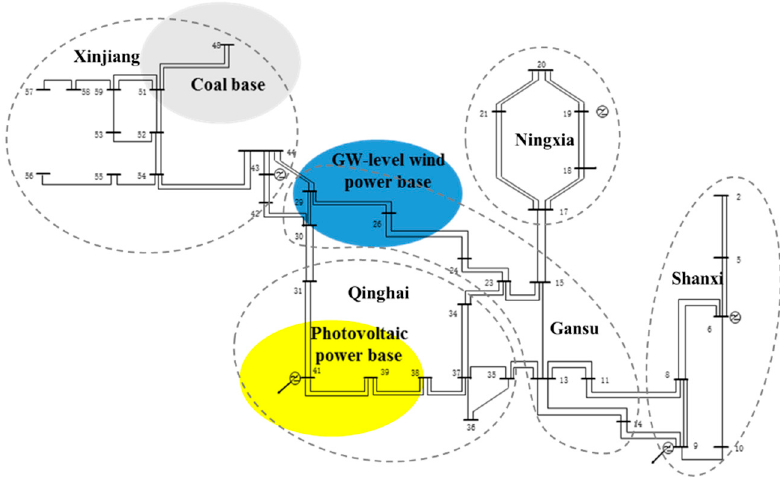
Figure 4. 750 kV power grid diagram of the Northwest power grid in 2014.